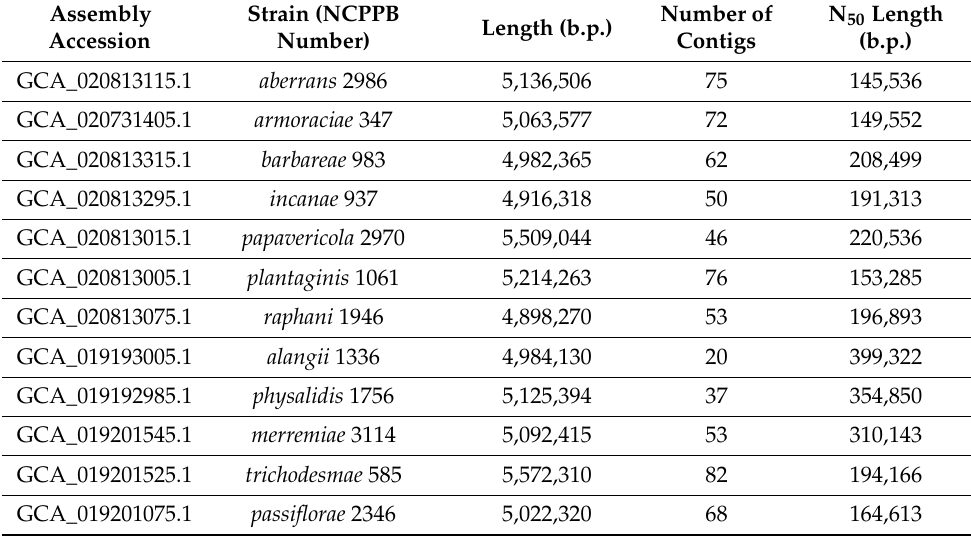
Table 2. Summary statistics for genome sequence assemblies. All data can be accessed via Bio- Projects PRJNA742925 and PRJNA774128. All sequences strains are the pathotype strains for their respective